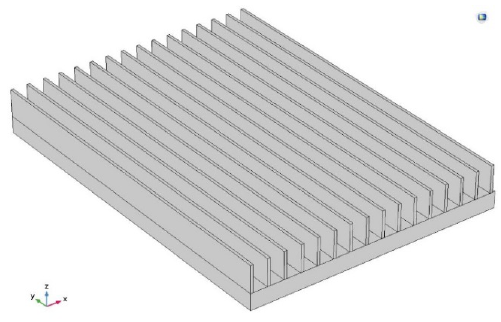
Figure 20. Heatsink for GaN model.